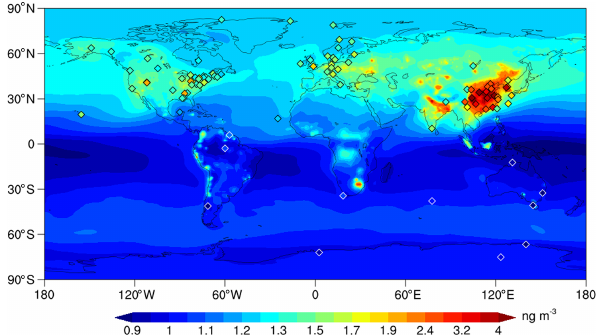
Figure 3. Global distribution of surface total gaseous mercury (TGM) concentrations. Model results (background) are annual aver- age of 2011–2013. Ground-based observations (rhombuses) are for 2009–2015 except for some observations in eastern Asia (see Ta- ble S1 in the Supplement for detailed description). The rhombuses with white frames are concentrations below 1.2ngm − 3 . Note that the scale of the color bar is non-uniform.